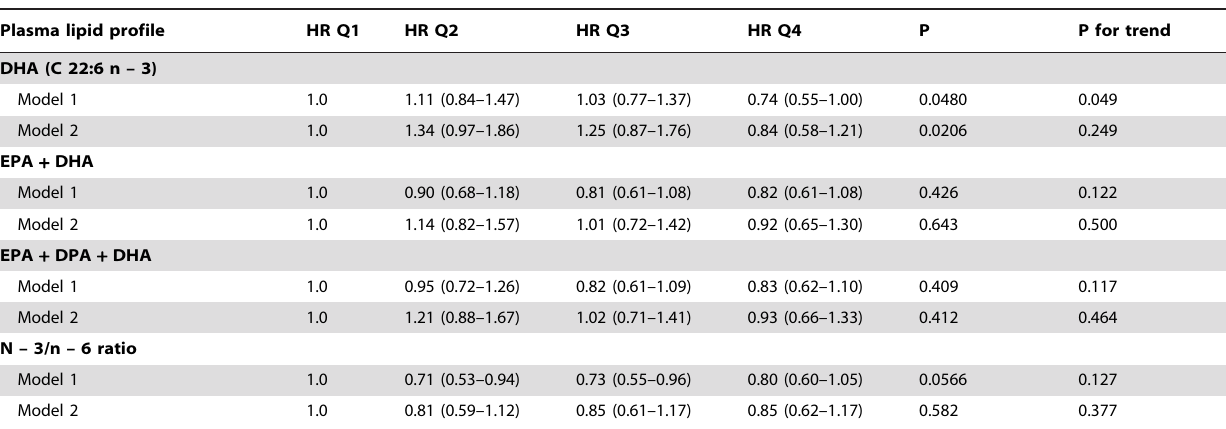
Model 1: adjusted for age, BMI, initial event, gender. Model 2: adjusted for covariates in Model 1 + treatment allocation group (both placebos, B vitamin and placebo of omega 3, omega 3 and placebo of B vitamins, omega 3 and B vitamins),, tobacco smoking, alcohol consumption, systolic blood pressure, diabetes status, plasma cholesterol (HDL and LDL), triglycerides, total fatty acid intake, n-3 supplementation and